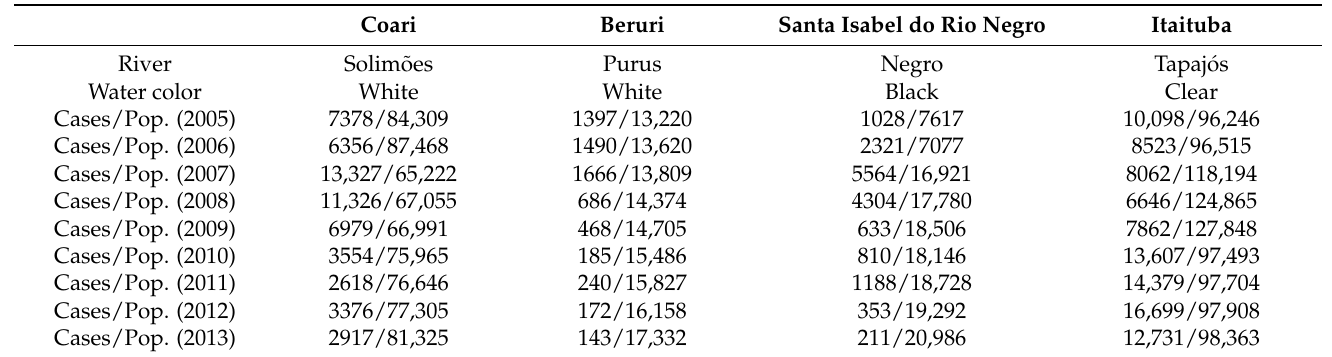
Table 1. River, water color, number of malaria cases (Cases) and population characteristics (Pop.) in the municipalities during the study